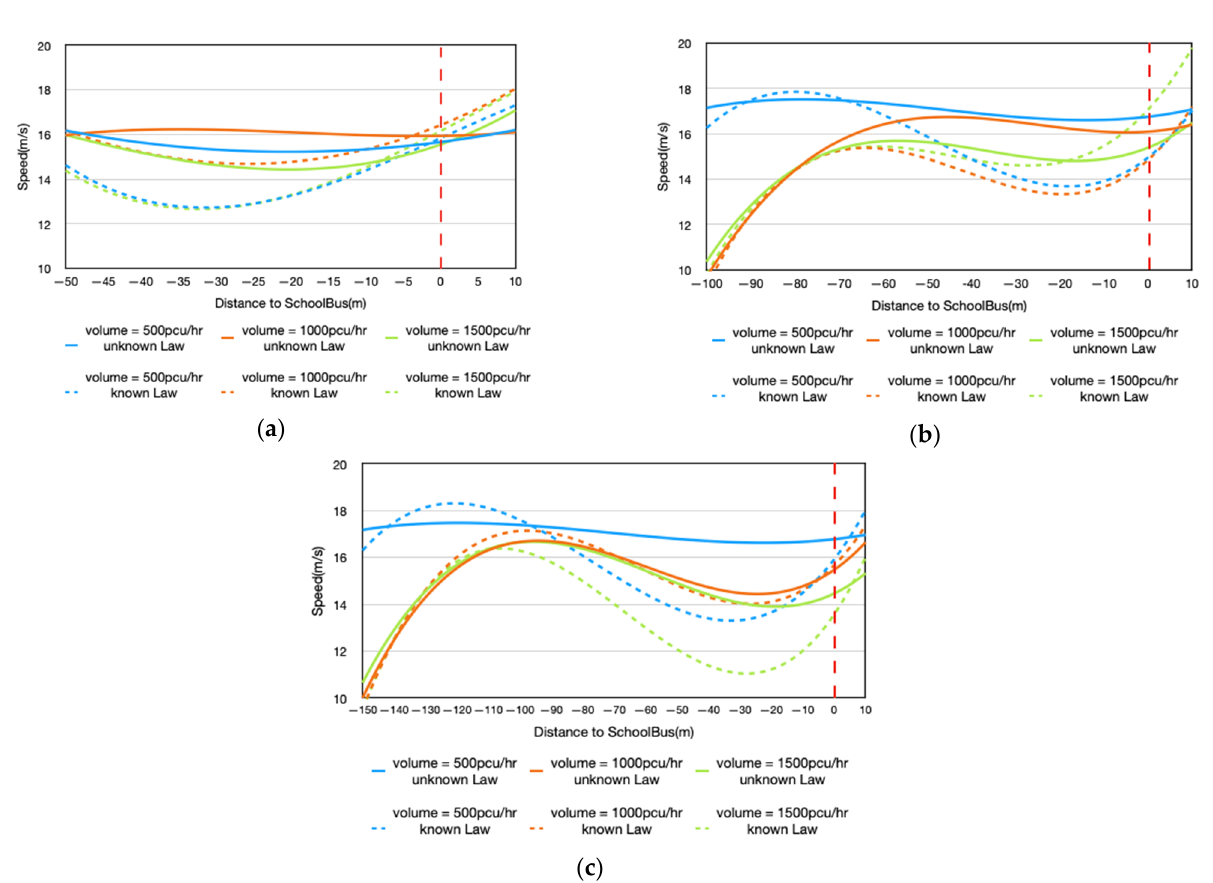
Figure 3. ( a ) Mean speed profiles under IDCTS = 50 m; ( b ) mean speed profiles under IDCTS = 100 m; ( c ) mean speed profiles under IDCTS = 150 m.